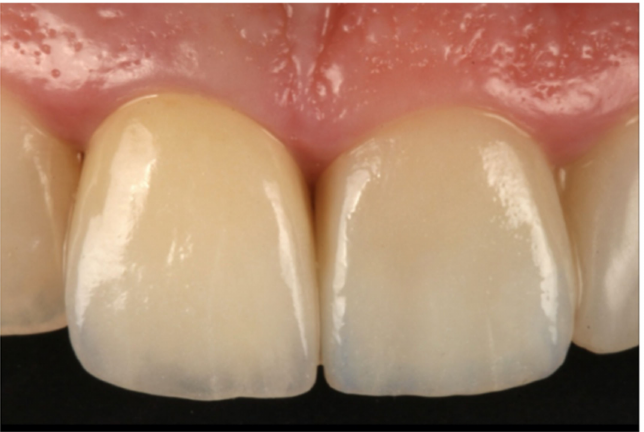
Figure 6. Final zirconia